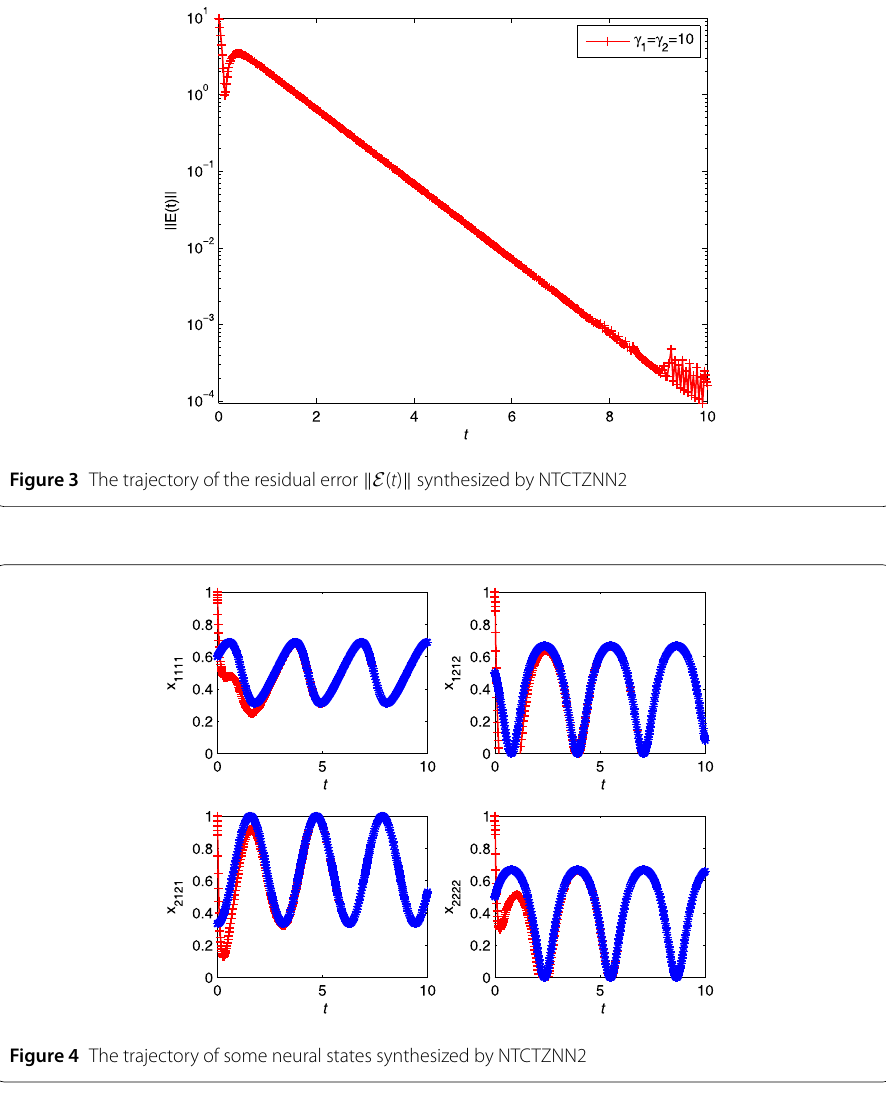
of the theoretical solution. (Here the theoretical solution X ∗ ( t ) is denoted by ∗ -dotted blue curves, and the neural-network solutions are denoted by +-dotted red